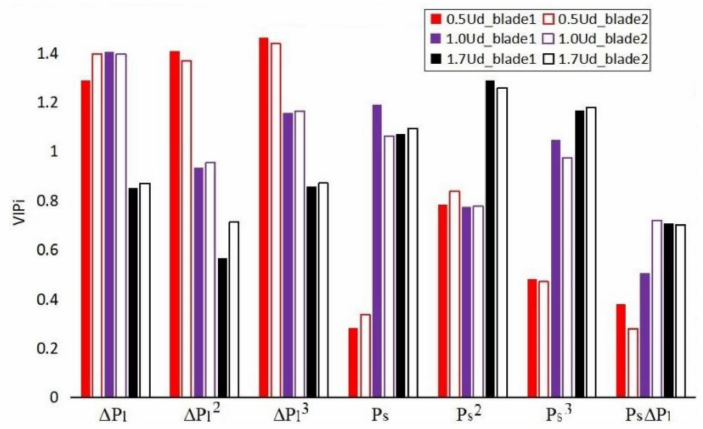
Figure 18. The calculated Variable Projection Importance indexes.